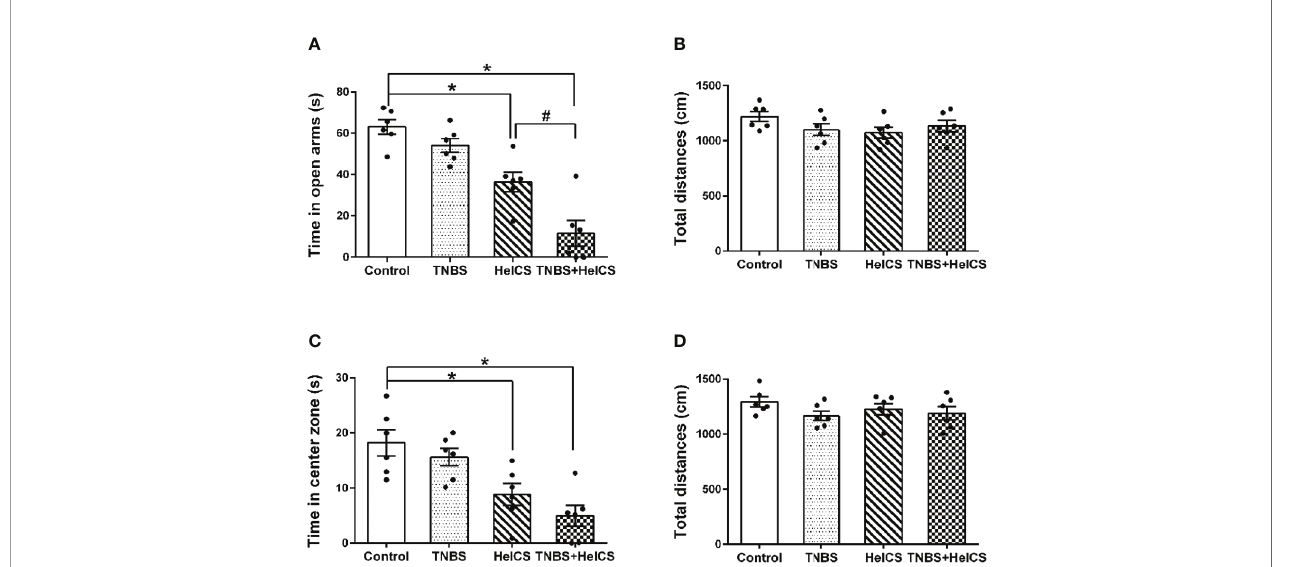
FIGURE 3 | The effects of 2,4,6-trinitrobenzene sulfonic acid (TNBS), heterotypic intermittent chronic stress (HeICS), and TNBS + HeICS application on the anxiety- like behaviors in the elevated plus maze (EPM) test and open fi eld test (OFT). (A) Bars showing that both HeICS and TNBS + HeICS application reduced time spent in open arms of the EPM signi fi cantly compared with the control group (n = 6 each; one-way ANOVA; * P < 0.05; # P < 0.05). (B) Bars showing that there were no signi fi cant differences of average total distance in the EPM (n = 6 each; one-way ANOVA). (C) Bars showing that both HeICS and TNBS + HeICS application observably reduced time spent in center zone compared with the control group (n = 6 each; one-way ANOVA; * P < 0.05). (D) Bars showing there were no signi fi cant differences of average total distance in the OFT (n = 6 each; one-way ANOVA). The data are presented as means ± standard error of means